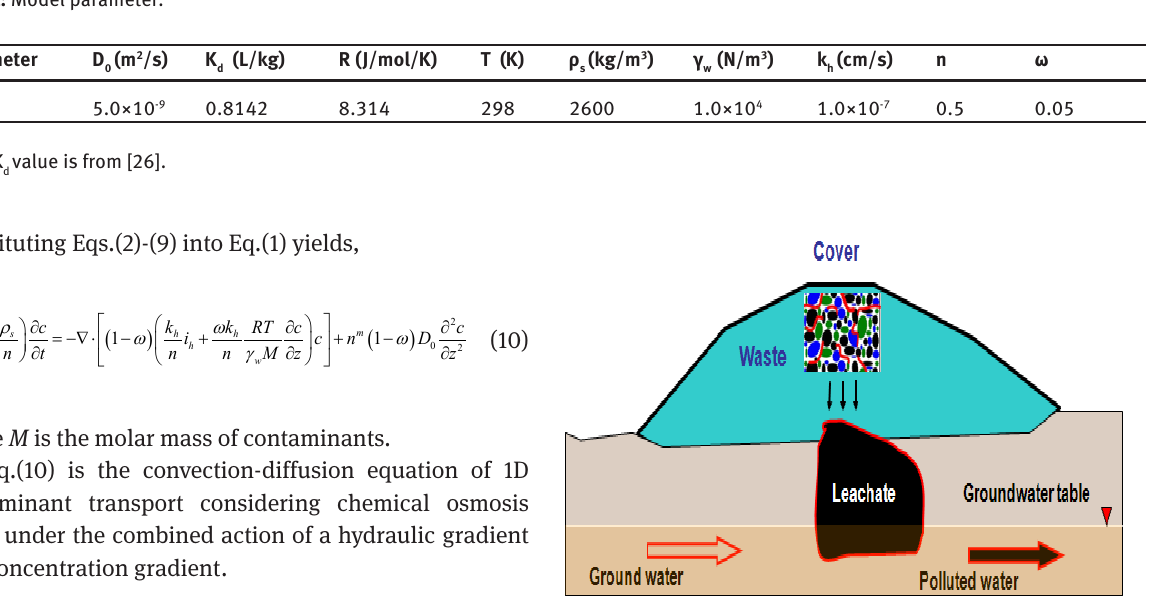
Figure 1: A schematic of clay liner.